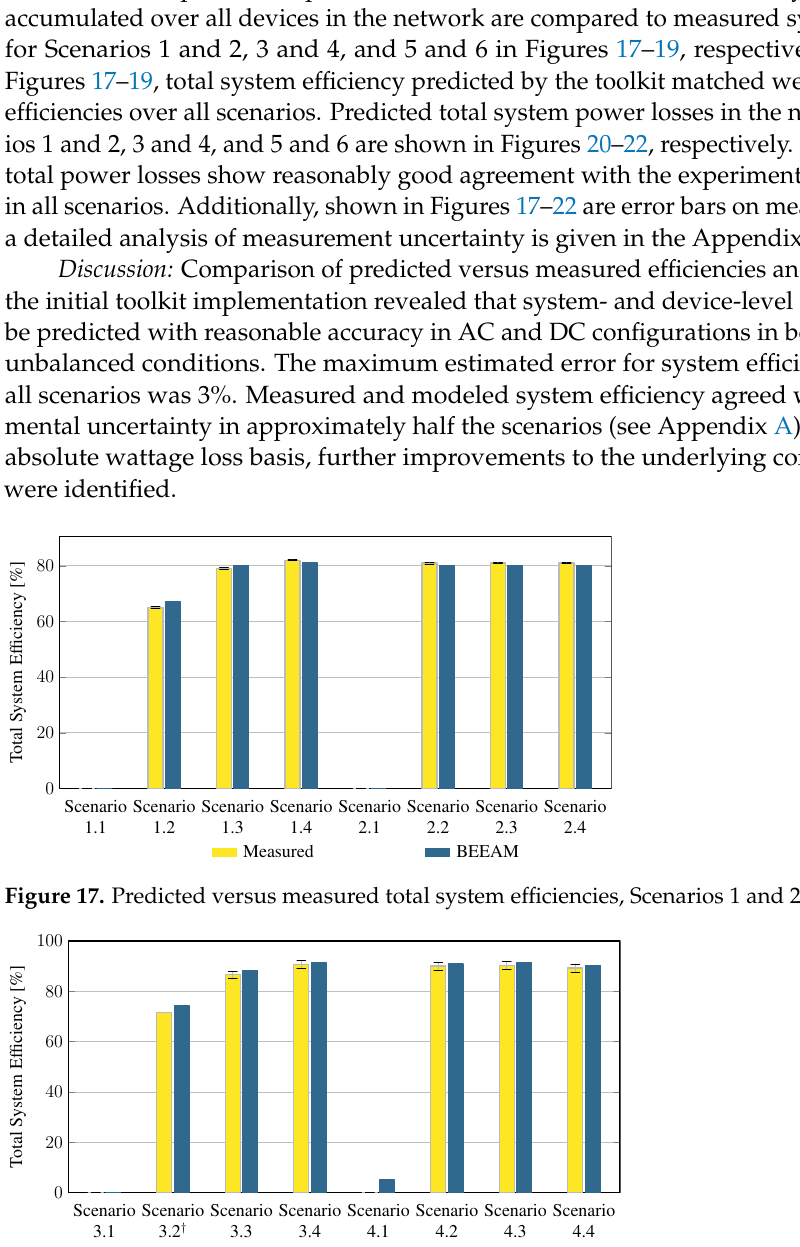
Scenario 3.1 Figure 18. Predicted versus measured total system efficiencies, Scenarios 3 and 4. † indicates that uncertainty could not be estimated; see Appendix